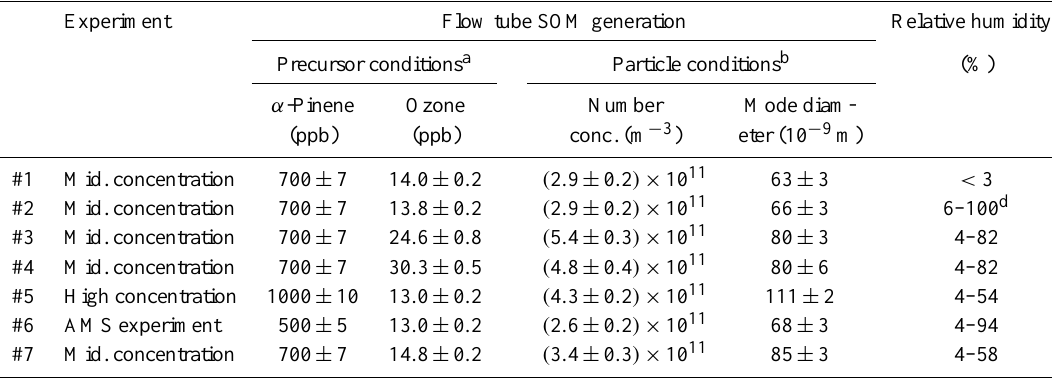
Table 1. Summary of experimental